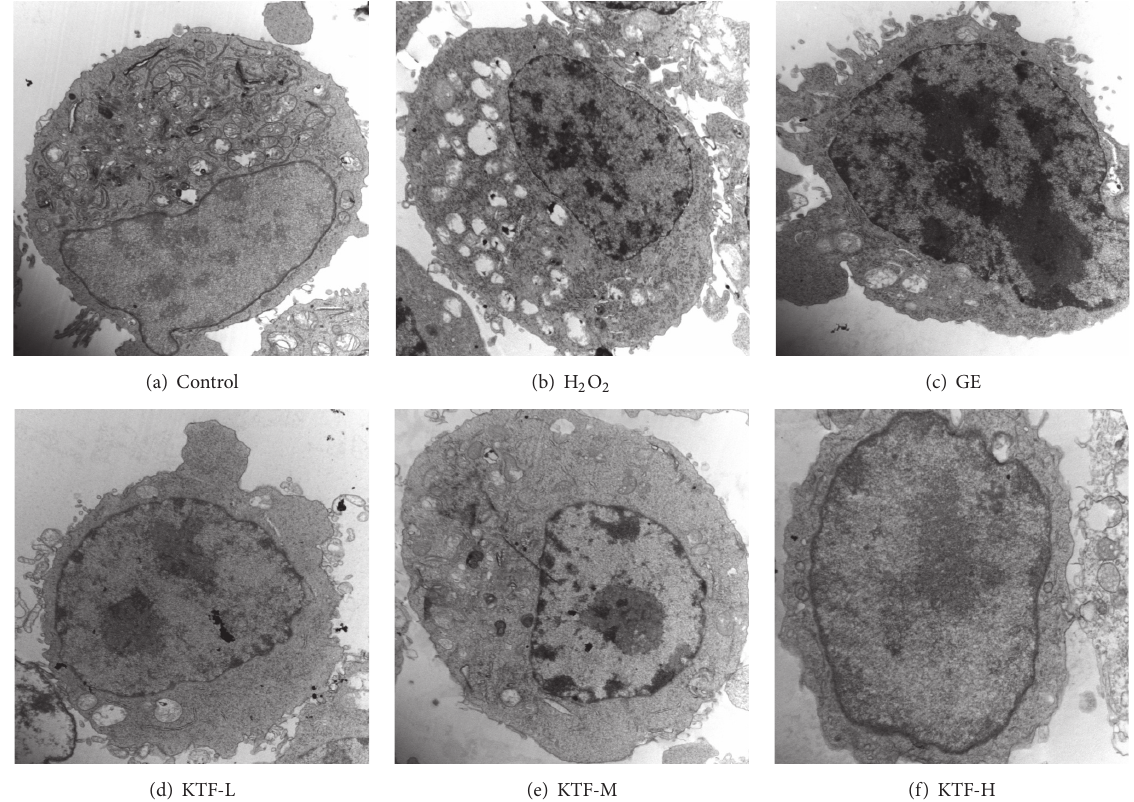
Figure 2: Effect of KTF on cellular ultrastructure in H 2 O 2 -induced MES23.5 cells. Cellular ultrastructure was observed under TEM. Normal morphology of cytoplasm, cell organelles in control group ((a), × 15,000), characteristic ultrastructural morphology of oxidative damage in H 2 O 2 -treated group ((b), × 15,000), treatment with KTF group (3.125, 6.25, and 12.5 𝜇 g/ml, respectively) ((d), (e), (f), × 15,000), or Ginkgo extract (12.5 𝜇 g/ml) ((c), ×